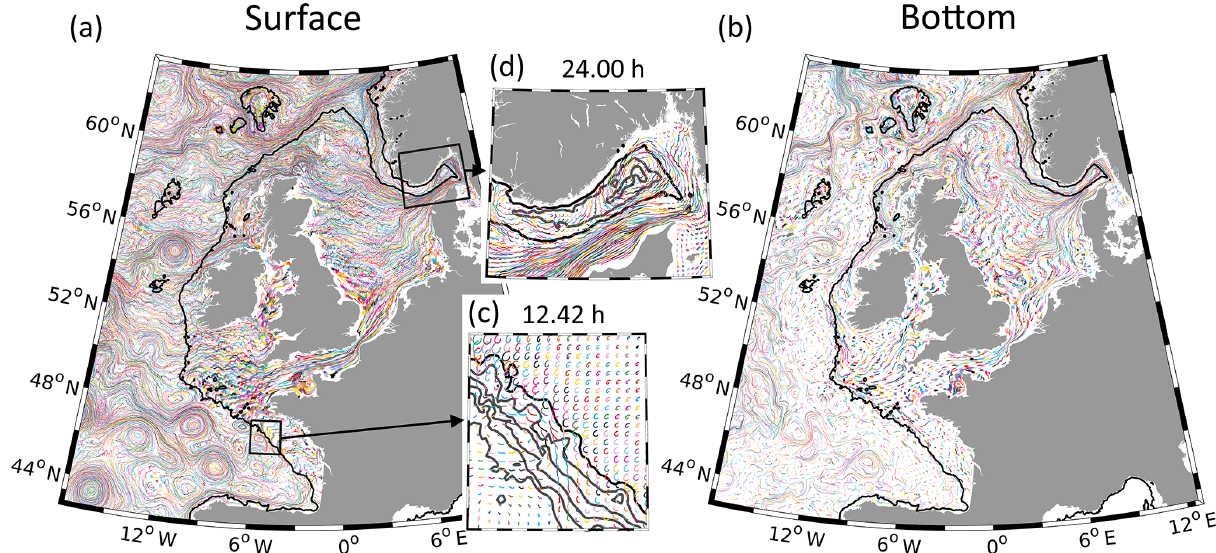
Figure 3. Lagrangian trajectories of every eighth particle after 15d of integration in the control run (CR, no. 1; see Table 1) released on 1 January 2015. Particles are released at (a) the surface and (b) bottom. Panels (c) and (d) are magnified views of the domain showing all trajectories of (c) the first 12.42h and (d) 24.00h representative of different dynamics: (c) the area of the Armorican Shelf continental slope including tidal ellipses and (d) the circulation in the Skagerrak. The trajectory colours are randomly chosen for better visibility. Grey lines are isobaths in (c) 800m and (d) 200m